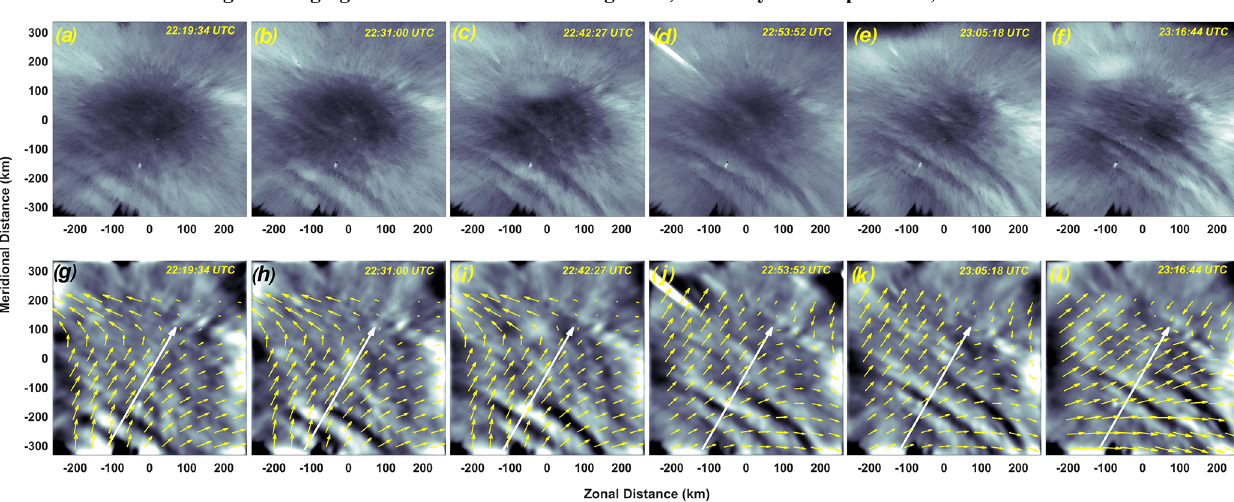
Figure 3. (a–f) Sequence of O 2 866.0nm airglow images on 25 April 2017 over northern Germany. (g–l) Corresponding 2D FFT filtered images overlaid on horizontal variation of wind field (yellow arrows) at the emission centroid height (94km) measured by MMARIA. The white arrow denotes the wave